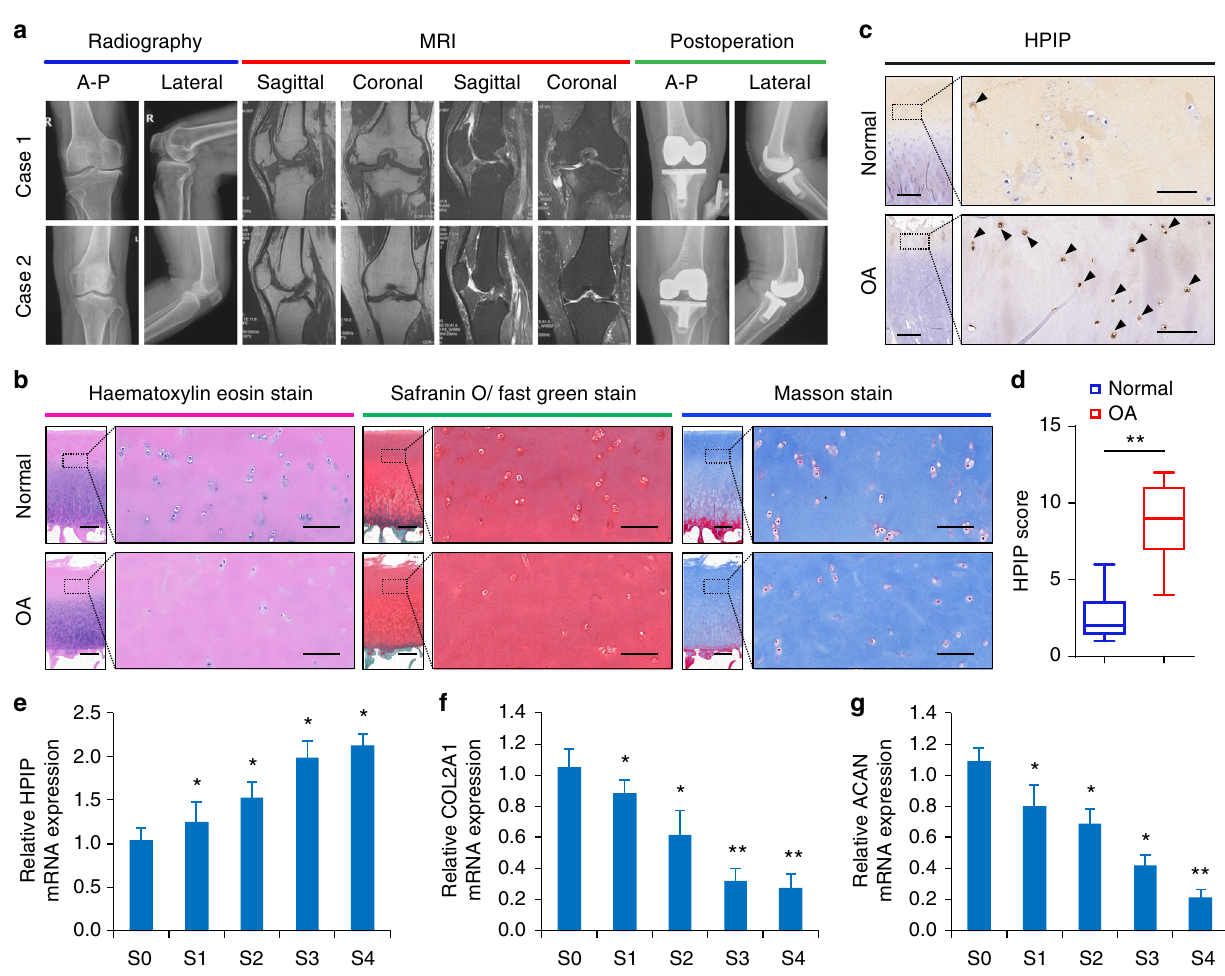
Fig. 1 HPIP expression is upregulated in osteoarthritis (OA) cartilage. a Representative plain radiographs and MRI images of patients with knee OA undergoing knee arthroplasty surgery. A – P anterior – posterior. b Representative histopathological staining of normal and OA cartilage tissues. Hematoxylin – eosin, safranin O/fast green and Masson trichrome staining were performed to examine the proteoglycan content in cartilage. Scale bar, left, 500 μ m; right, 200 μ m. c Immunohistochemistry assay with anti- HPIP in normal and OA cartilage tissues. Scale bar, left, 500 μ m; right, 50 μ m. d The HPIP scores in normal ( n = 118) and OA ( n = 118) cartilage tissues based on an immunohistochemistry assay were compared with the Mann – Whitney U -test. Center value represents the median of the HPIP scores. The bounds of box represent the upper quartile and the lower quartile. The whiskers represent the maximum and minimum score. e qRT-PCR measurement of HPIP in cartilage tissues obtained from stage 0 (S0) to stage 4 (S4). f qRT-PCR measurement of COL2A1 in cartilage tissues obtained from stage 0 (S0) to stage 4 (S4). g qRT-PCR measurement of ACAN in cartilage tissues obtained from stage 0 (S0) to stage 4 (S4). Error bar represents the standard deviation (s.d.) and P- value was generated by using one-way ANOVA with Tukey ’ s post hoc test. * P < 0.05; ** P <